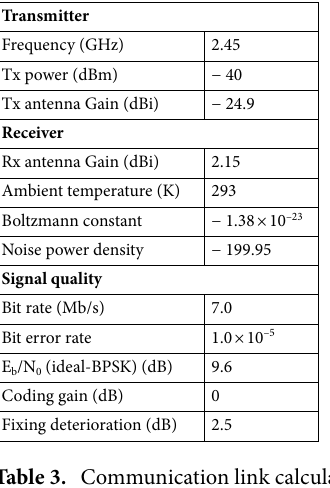
Table 3. Communication link calculation related parameters.